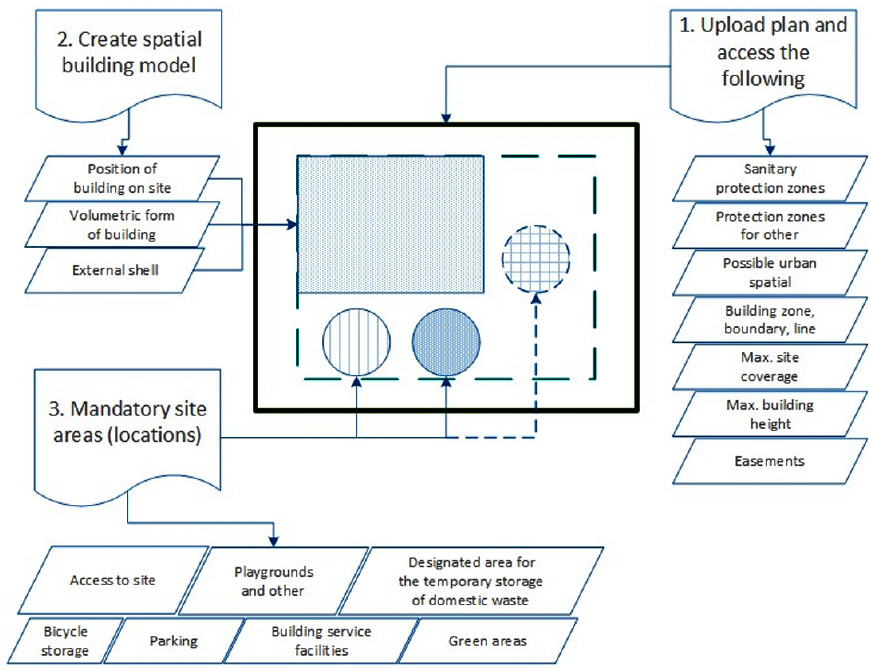
Fig. 4. Diagram of spatial site and building planning process